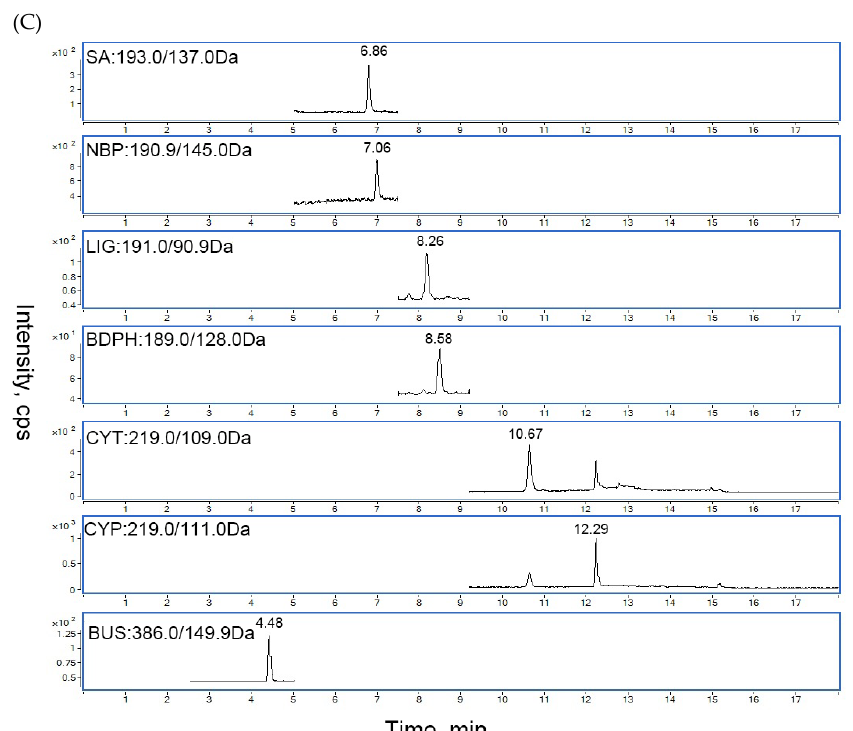
Figure 5. Typical chromatograms of ( A ) blank rat cerebral cortex homogenate; ( B ) blank rat cerebral cortex homogenate spiked with SA, NBP, LIG, BDPH, CYT and CYP and IS; ( C ) an unknown rat cerebral cortex homogenate sample after oral administration of 6.6 g/kg CRCR extract.